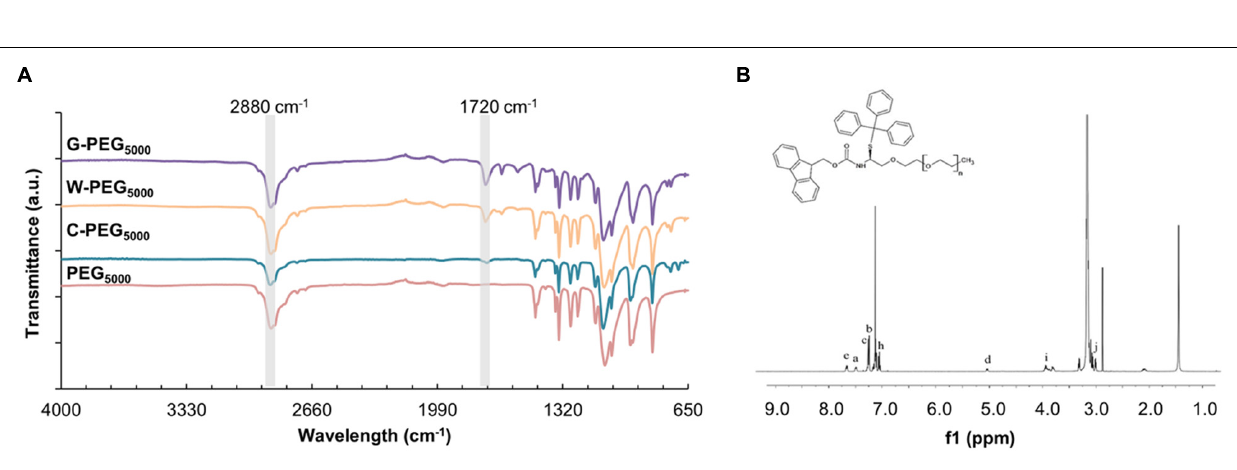
FIGURE 7 | (A) FT-IR spectrum of G-PEG 5000 , W-PEG 5000 , C-PEG 5000 , and PEG 5000 (B) 1 H NMR spectrum of C-PEG 5000